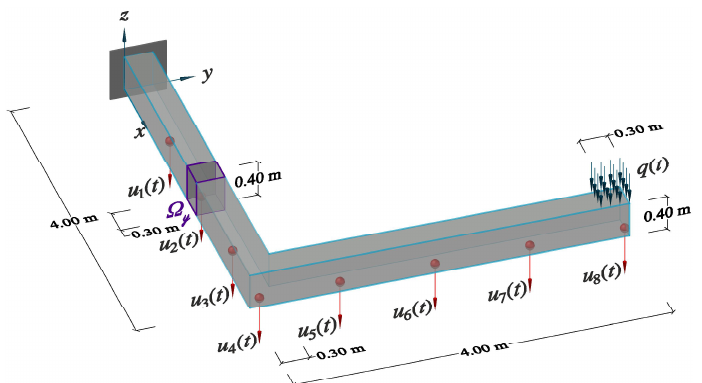
Figure 1. Cantilever beam: geometry, loading condition, damaged area Ω y , and synthetic recordings related to displacements u 1 ( t ) , . . . , u 8 ( t )